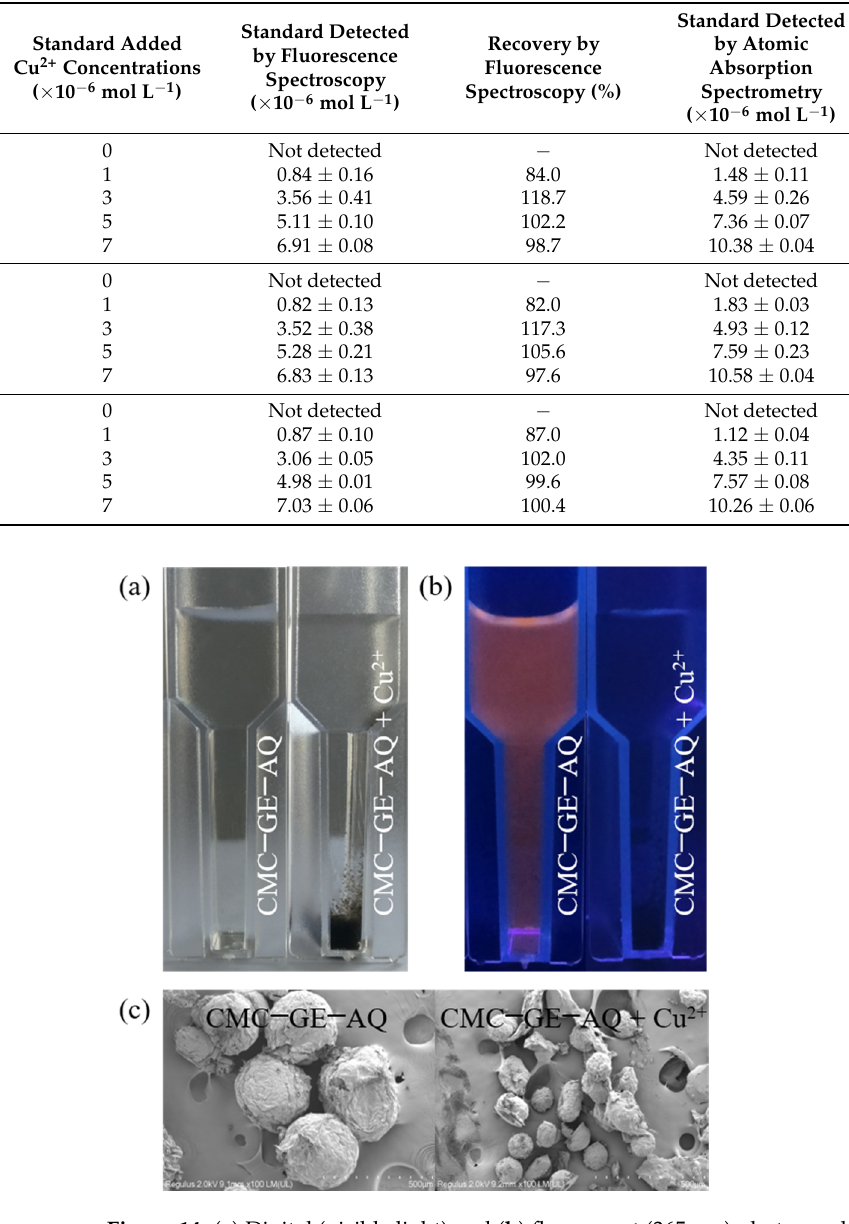
Figure 15. CLSM of CMC−GE−AQ microspheres with ( a ) several typical metal ions (10 −4 mol L −1 ) and ( b ) different concentrations of Cu 2+ (0, 6, 10, 30 and 60 × 10 −6 mol L −1 ); ( c ) fluorescent photographs of CMC−GE−AQ suspension with different concentrations (0, 6, 10, 30 and 60 × 10 −6 mol L −1 ) under 365 nm UV lamp. (CMC−GE−AQ: 1.5 × 10 −4 g mL −1 ; solvents: DMF/H 2 O solution ( v / v = 8/2, pH = 7); excitation wavelength: 425 nm; excitation slit: 5 nm). 4. Conclusions In summary, a simple fluorescent probe CMC−GE−AQ for the detection of Cu 2+ was successfully prepared. Upon coordination with Cu 2+ , the fluorescent color of CMC−GE−AQ changed significantly from orange to colorless. CMC−GEj−AQ exhibited a